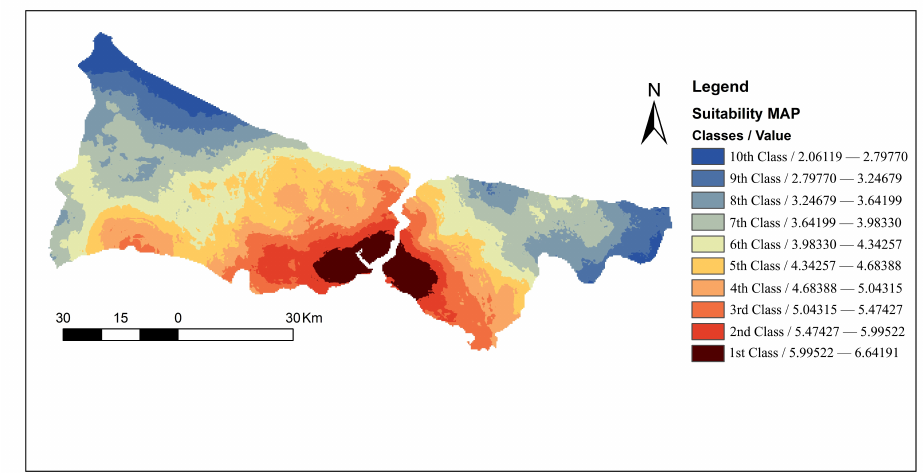
Figure 6. Suitability map for